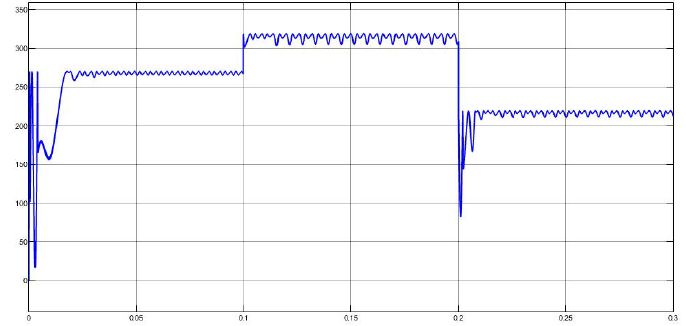
Figure 16. Performance of P&O MPPT (small step size).